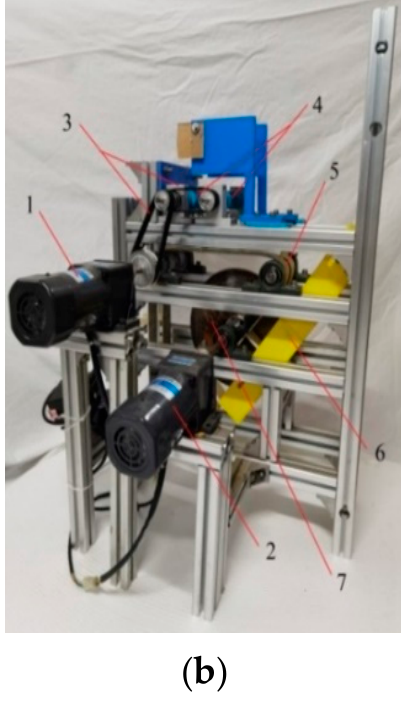
Figure 16. Equipment assembly diagram: ( a ) Physical picture of secondary cutting overall equipment including screening mechanism and spiral attitude-adjusting mechanism, double-baffle conveyor belt, block-centering chute, and disc-type cutter; ( b ) Physical picture in another perspective of secondary cutting overall equipment without screening mechanism, where 1. Delivery motor; 2. Tool motor; 3. Drive Belt; 4. Double spiral rod; 5. Baffle conveyor belt; 6. Centering chute; and 7. Disc cutter.